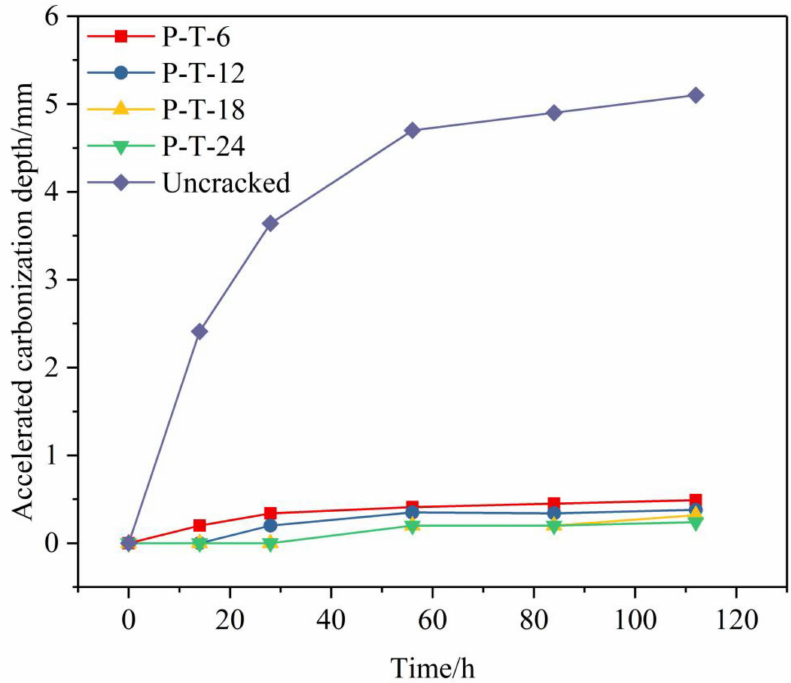
Figure 9. Accelerated carbonization depth of different mortars.